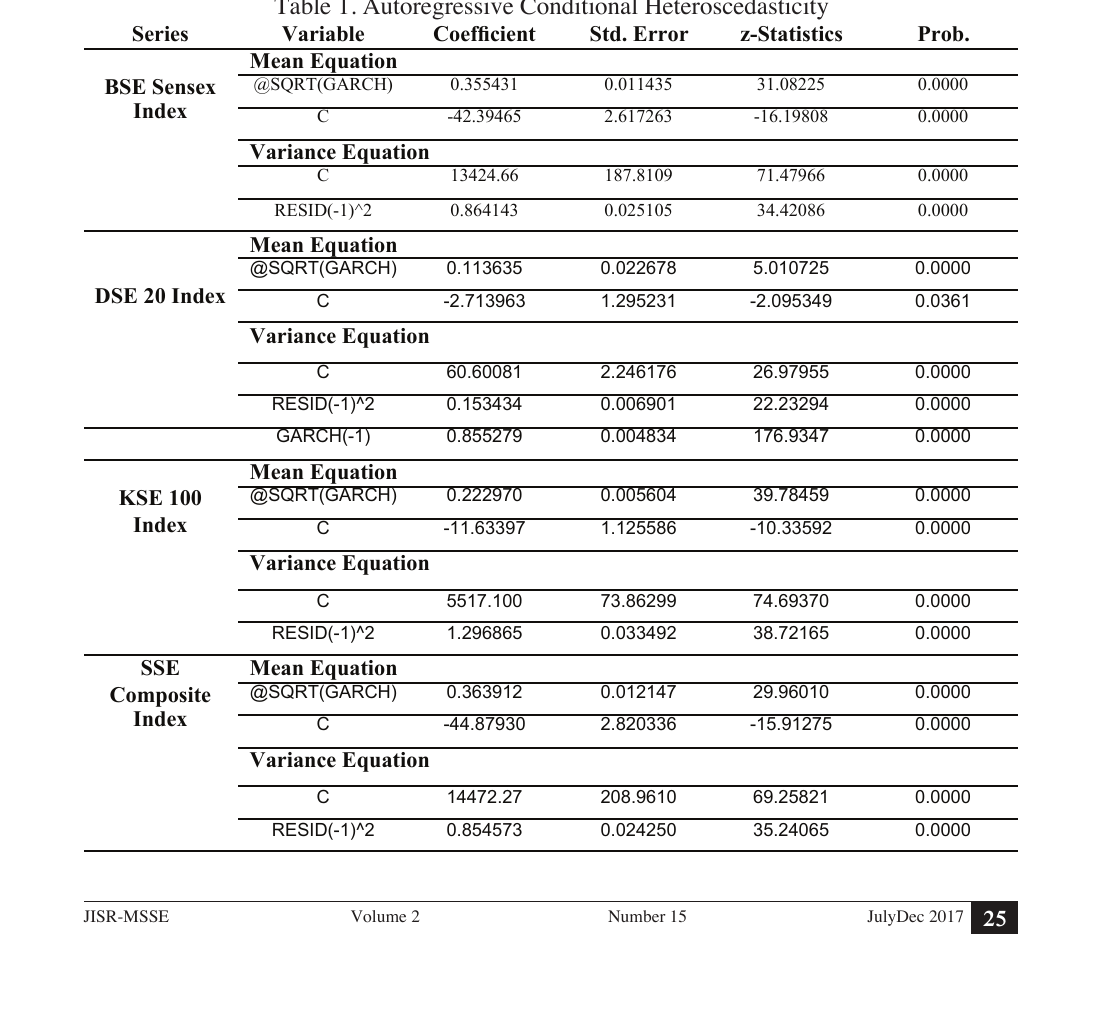
Table 1. Autoregressive Conditional